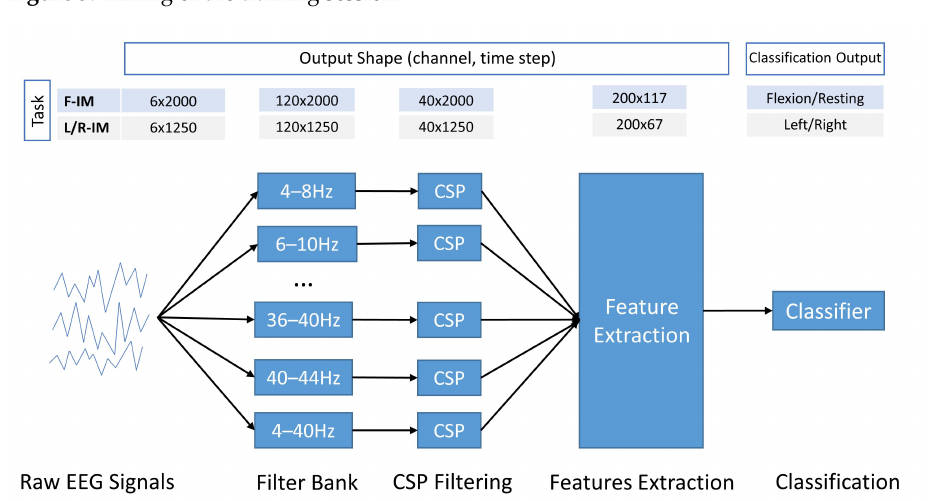
Figure 4. EEG processing pipeline: the output shape after each step is listed in the above